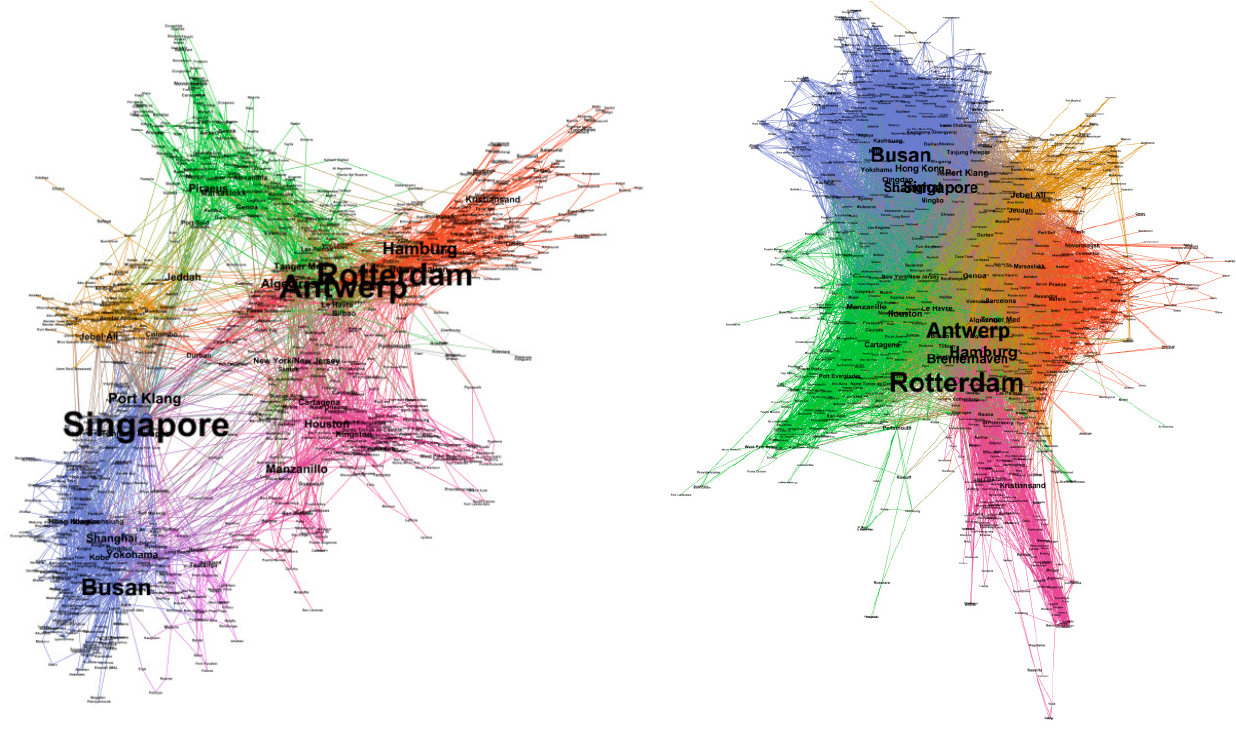
Figure 3. MCS network developed by the GDL-1 and GAL-1 models (2016).